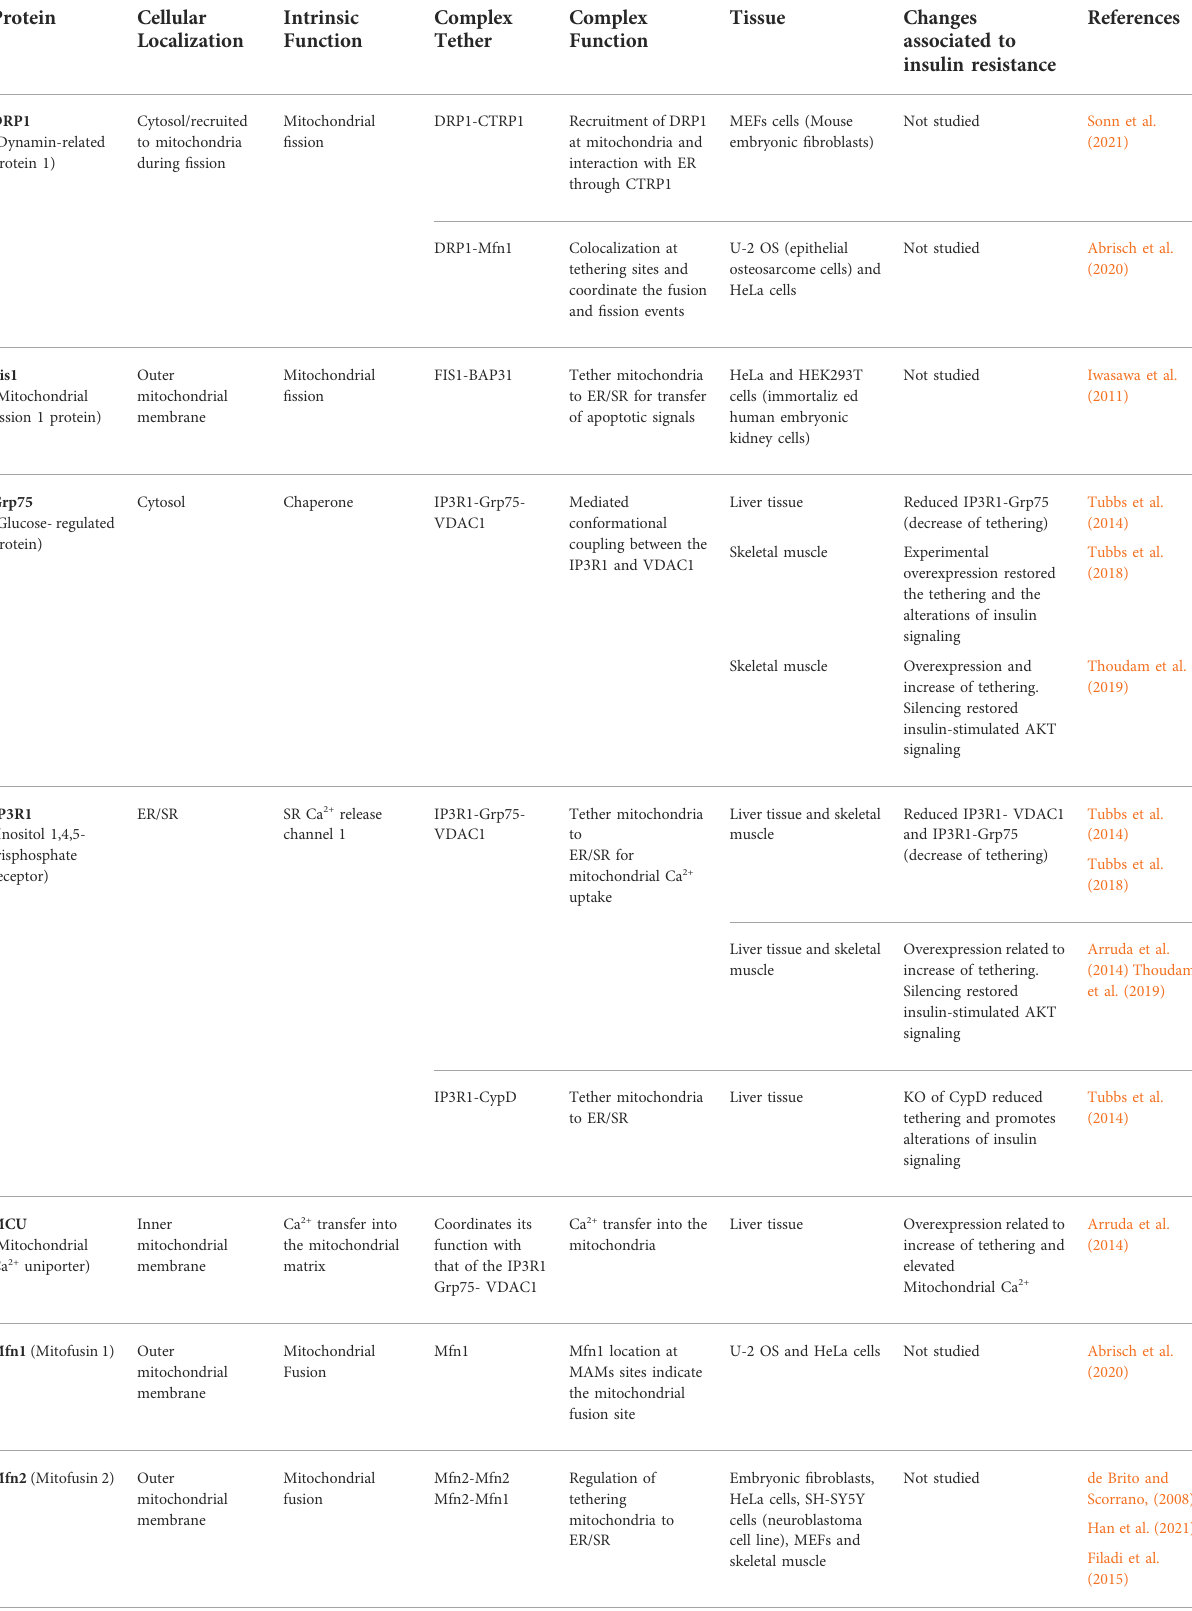
TABLE 1 Main proteins and protein complexes involved in MAMs and IR in skeletal muscle and other